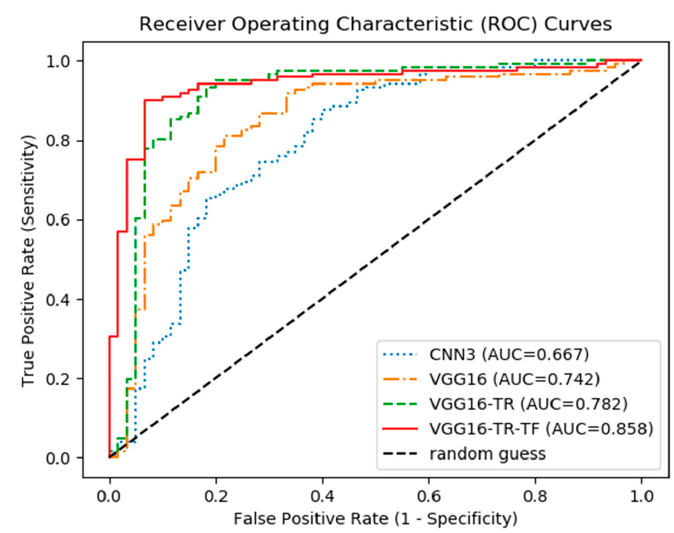
J. Clin. Med. 2020 , 9 , 392 Figure 4. Mean ROC curves of each CNN models for screening osteoporosis on DPR images in this study.